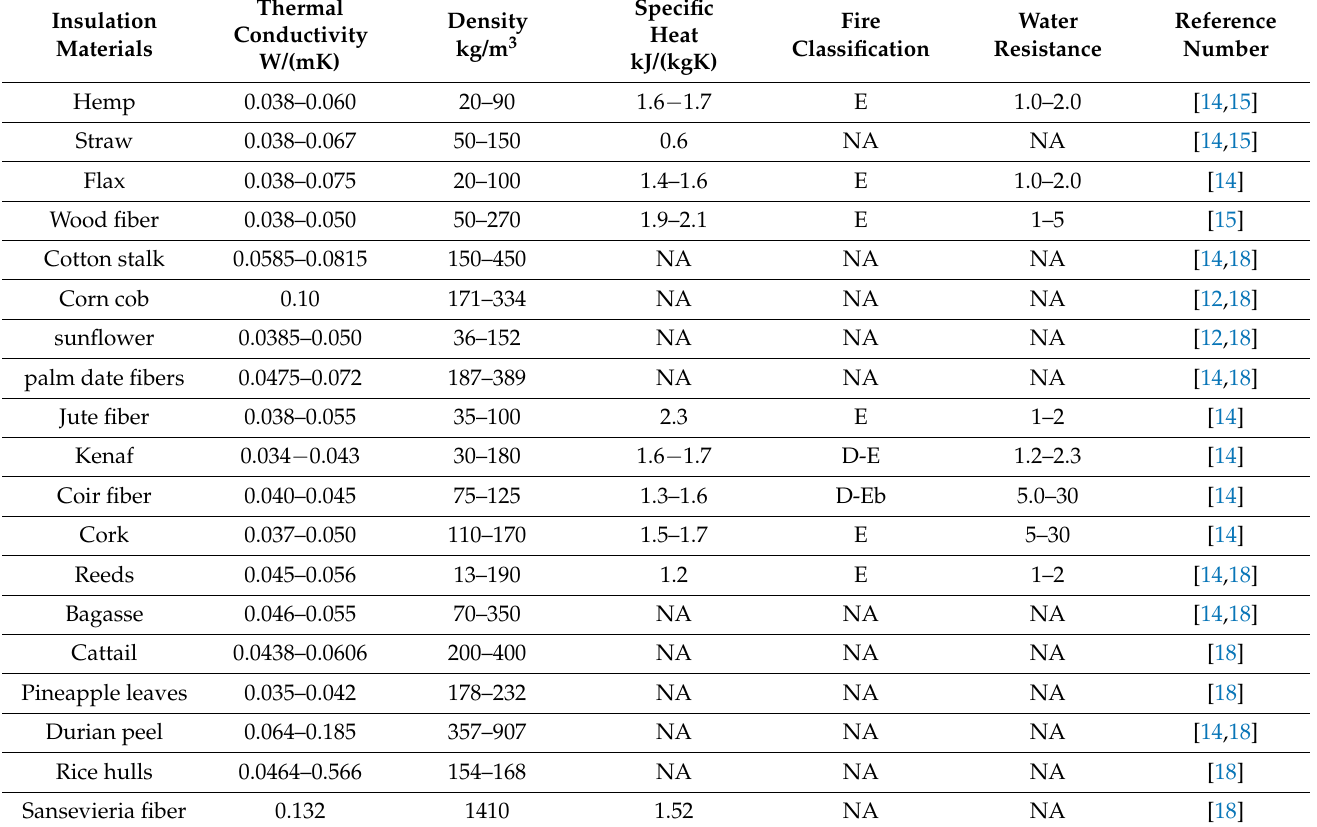
Table 1. Physical performance parameters for most bio-based insulation materials